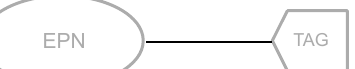
Figure 2.58: The Process Description glyph for Equivalence arc .